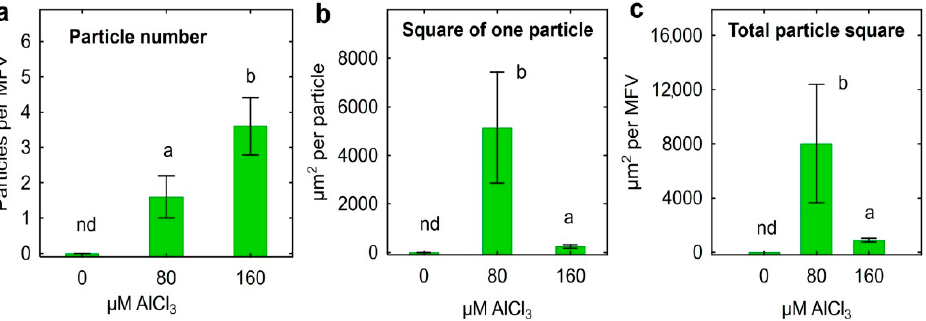
Figure 3. The number ( a ) and size ( b , c ) of clumps formed by Pseudomonas fluorescens SPB2137gfp in batch culture supplemented with 80 or 160 µm AlCl 3 . Vertical bars show standard errors. Different letters show significant differences between treatments (Student’s t -test, p < 0.05, n varied from 5 to 18 depending on the parameter and treatment). nd stands for not detected.